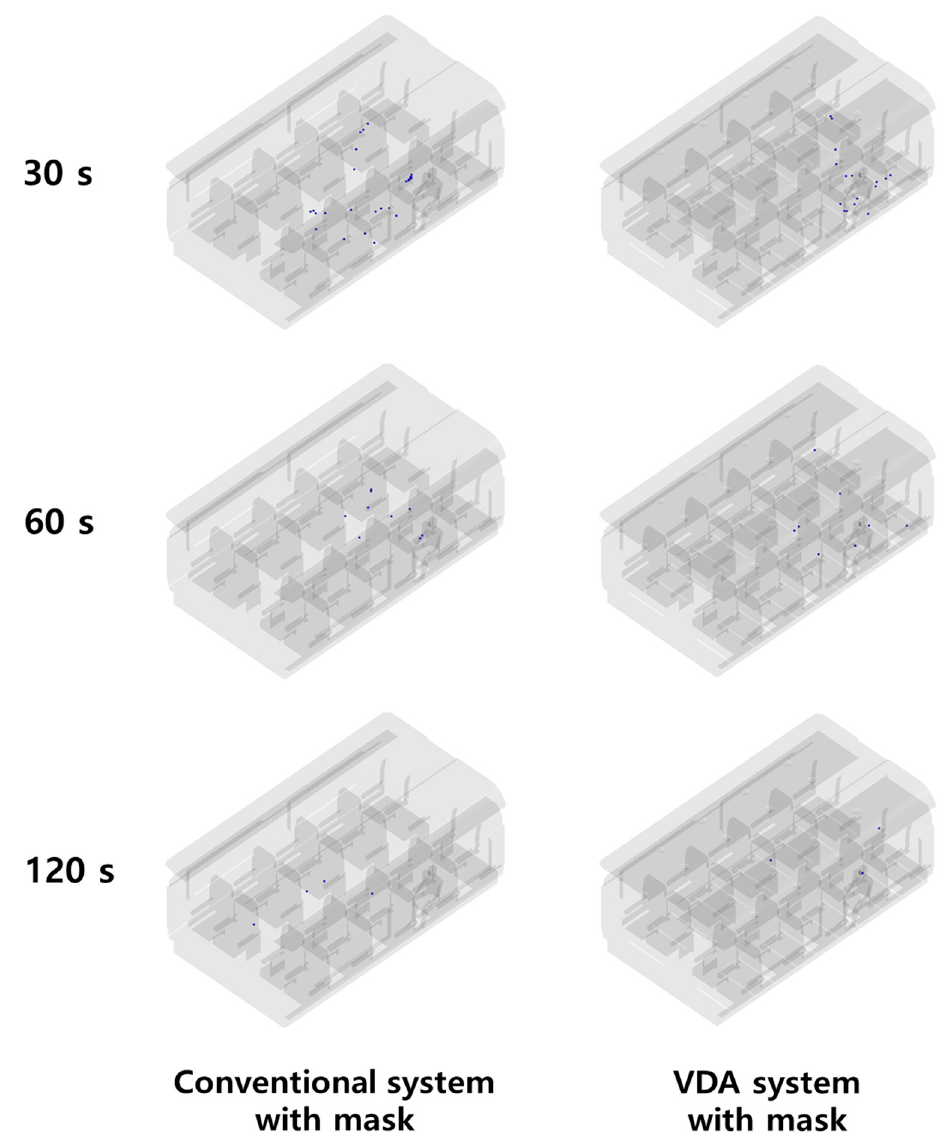
Figure 14. Droplet distributions in the conventional and VDA systems with the mask between 30 and 120 s after coughing. The droplet size is uniform.